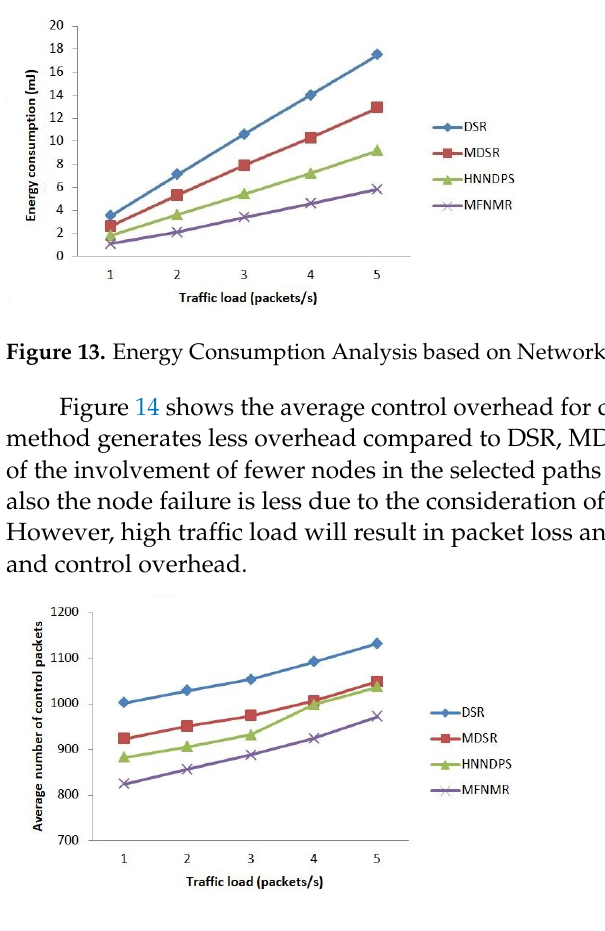
Figure 14. Routing Overhead Analysis based on Network Traffic.